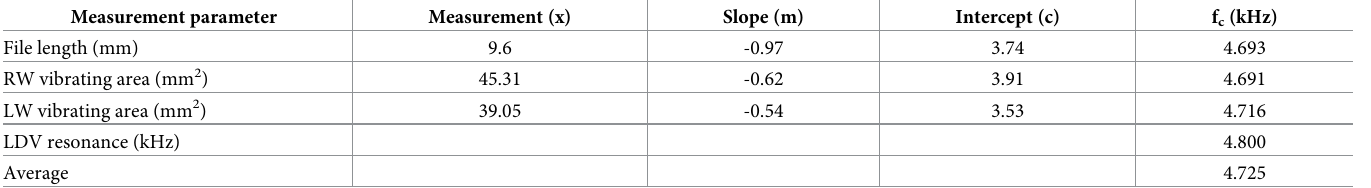
Table 1. Model measurement parameters for calculation of the likely carrier frequency (f c ) of Prophalangopsis obscura . Measurement